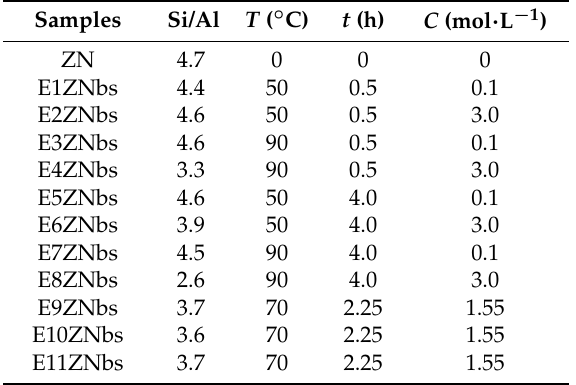
Table 2. Si/Al ratio for samples without and with basic treatment. ZN: zeolite. Samples Si/Al T ( ◦ C) t (h) C (mol · L − 1